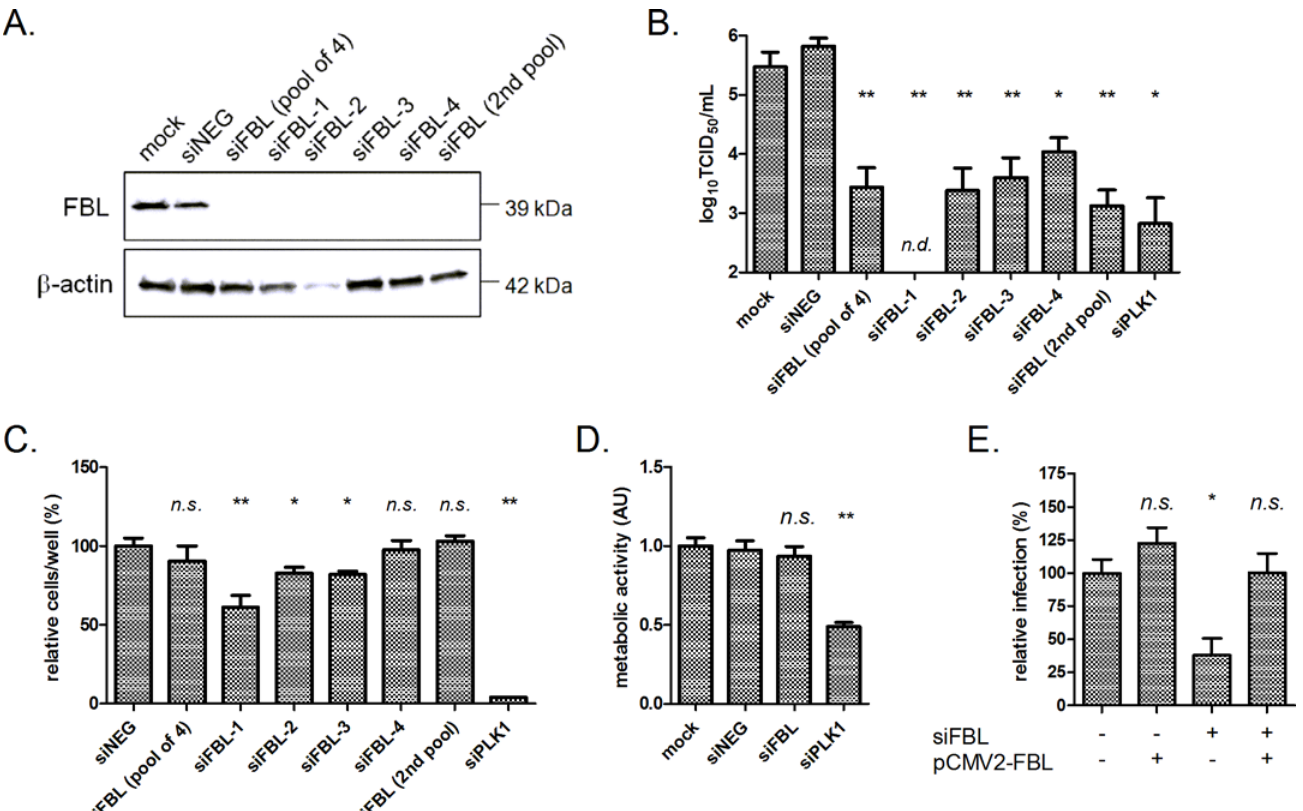
Fig 2. FBL is required for HeV infection. (A) Western blot analysis of HeLa cells transfected with indicated siRNAs. siFBL SMARTpool refers to the 4 siRNA duplexes used to silence FBL in the genome-wide siRNA screen, while siFBL-1, 2, 3, and 4 are the individual constituent duplexes. siFBL (2 nd pool) refers to the ON-TARGETplus SMARTpool siRNA with modified chemistry to reduce off-target effects (Dharmacon RNA Technologies). Lysates were collected 72 h post-transfection. (B) HeV titres in HeLa cells infected with HeV (MOI 0.1) for 48 h, 72 h post-transfection with siRNAs. * p < 0.05, ** p < 0.01 compared to siNEG, n.d. not detected. (C) Cell numbers 72 h post-transfection with siRNAs. Data is normalised to siNEG values. * p < 0.05, ** p < 0.01 compared to siNEG, n.s. not significant. (D) Relative cell metabolic activity, measured by Alamar blue assay, in cells transfected with siRNAs as described above. ** p < 0.01 compared to siNEG, n.s. not significant compared to siNEG. (E) HeV infection in cells depleted of endogenous FBL +/- a vector (pCMV2, 500 ng, 24 h) expressing FBL resistant to siRNA, followed by HeV infection (MOI 0.1, 24 h). Relative infection refers to the percentage of cells stained positive for HeV phosphoprotein. * p < 0.05 compared to siFBL(-) pCMV2-FBL(-) cells, n.s. not significant compared to siFBL (-) pCMV2-FBL(-) cells.